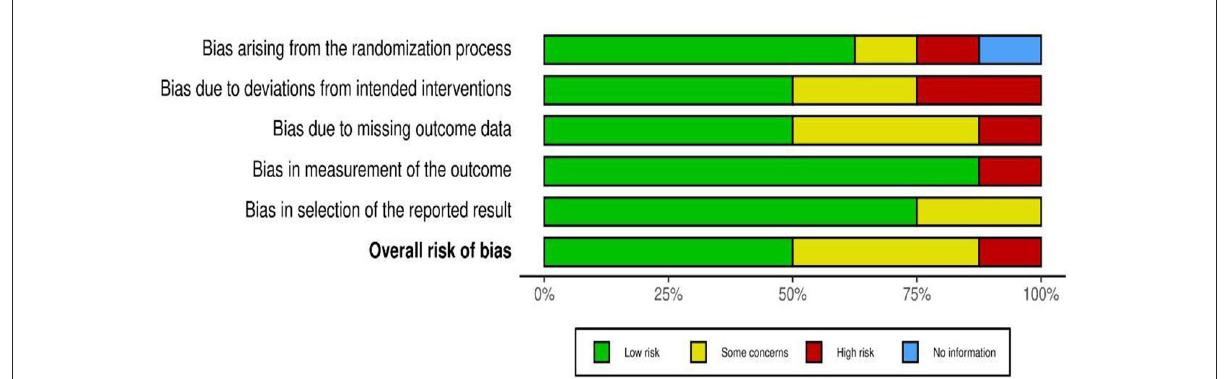
FIGURE2 Robvis output for risk bias assessment.